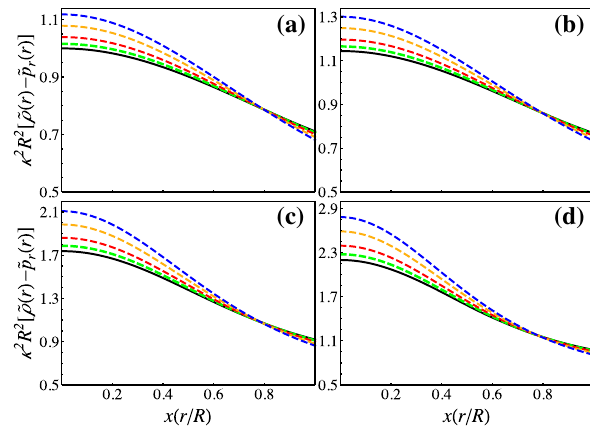
Fig. 3 Effective tangential pressure ˜ p t . For a u = 0 . 13, b u = 0 . 15478, c u = 0 . 2035, d u = 0 . 229365. α = 0 (black solid line), α = 0 . 04, (green dashed line), α = 0 . 1 (red dashed line), α = 0 . 2 (yellow dashed line), α = 0 . 3 (blue dashed line)